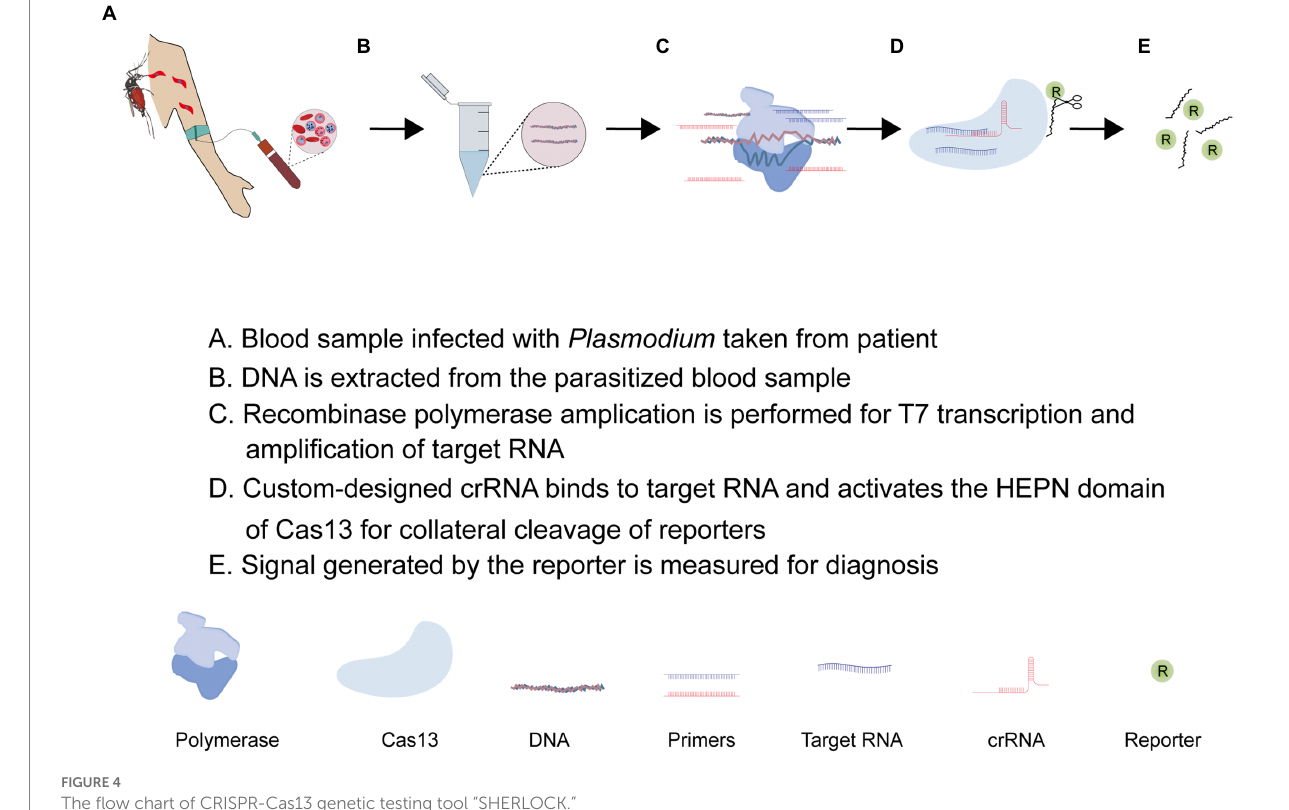
FIGURE 4 The flow chart of CRISPR-Cas13 genetic testing tool